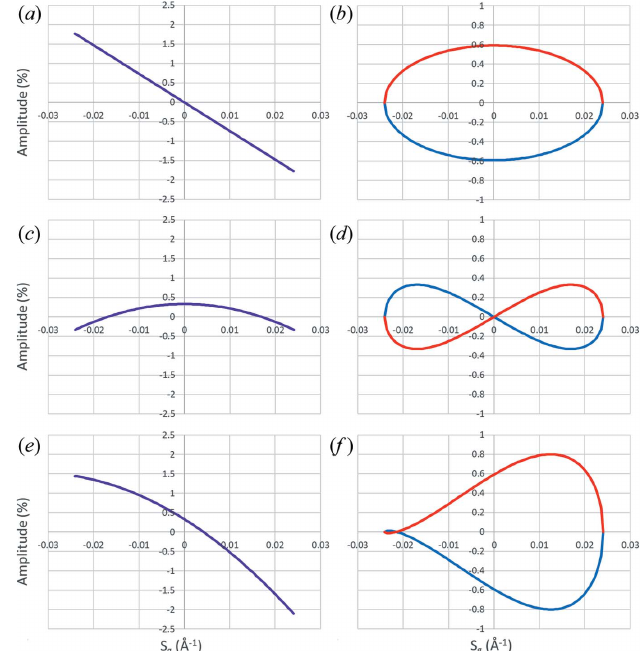
Figure 8 Excitation error ( S g )-dependent effects of the image tilt induced parabolic and elliptical distortions on the position of a reflection, with the distance from the centre of the distortions equal to 1.5 A˚ (cid:5) 1 and with the amplitudes of the induced distortions the same as those found experimentally for the PED experiment DS8. For the sake of clarity, the phases of the distortions are set exactly to 0 (cid:2) so the radial components cause only reflection shifts and the tangential components cause only reflection splitting. The left-hand column shows the shift effects of the radial components of ( a ) the parabolic distortion, ( c ) the elliptical distortion and ( e ) their combination. Similarly, the right-hand column shows the splitting effects of the tangential parts of ( b ) the parabolic distortion, ( d ) the elliptical distortion and ( f ) their combination. Blue lines correspond to phases of the precessed electron beam between 0 and (cid:5) , red lines correspond to phases between (cid:5) (cid:5) and 0, and purple lines correspond to phases between (cid:5) (cid:5) and (cid:5)